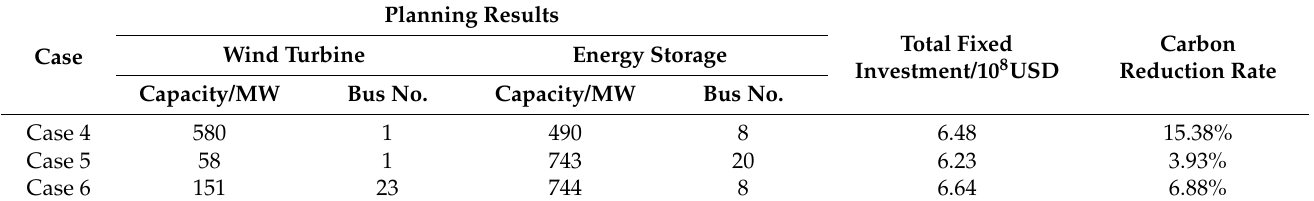
Table 8. Planning results of different cases in Scenario 2.